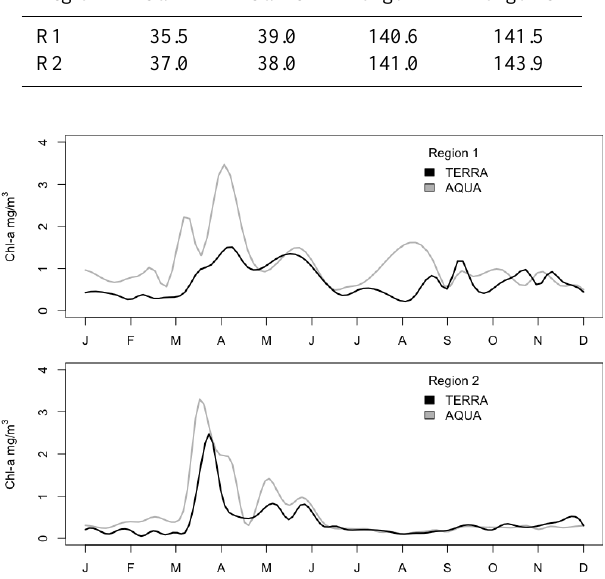
Figure 3. Average chlorophyll concentration for Region 1 and Re- gion 2 for year 2011 retrieved by NASA MODIS onboard TERRA and AQUA. The concentrations are in a logarithmic